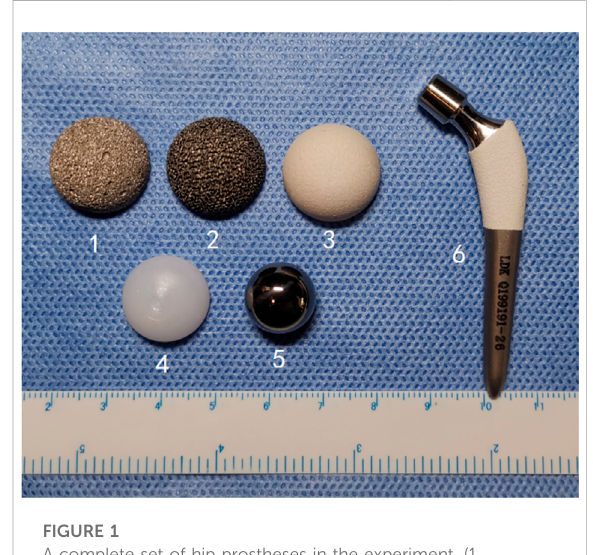
FIGURE 1 A complete set of hip prostheses in the experiment. (1, sintered porous titanium alloy acetabular cup; 2, 3D-printed porous titanium alloy acetabular cup; 3, HA-coated titanium alloy acetabular cup; 4. UHMWPE lining; 5. CoCrMo femoral head; 6. HA-coated titanium alloy femoral